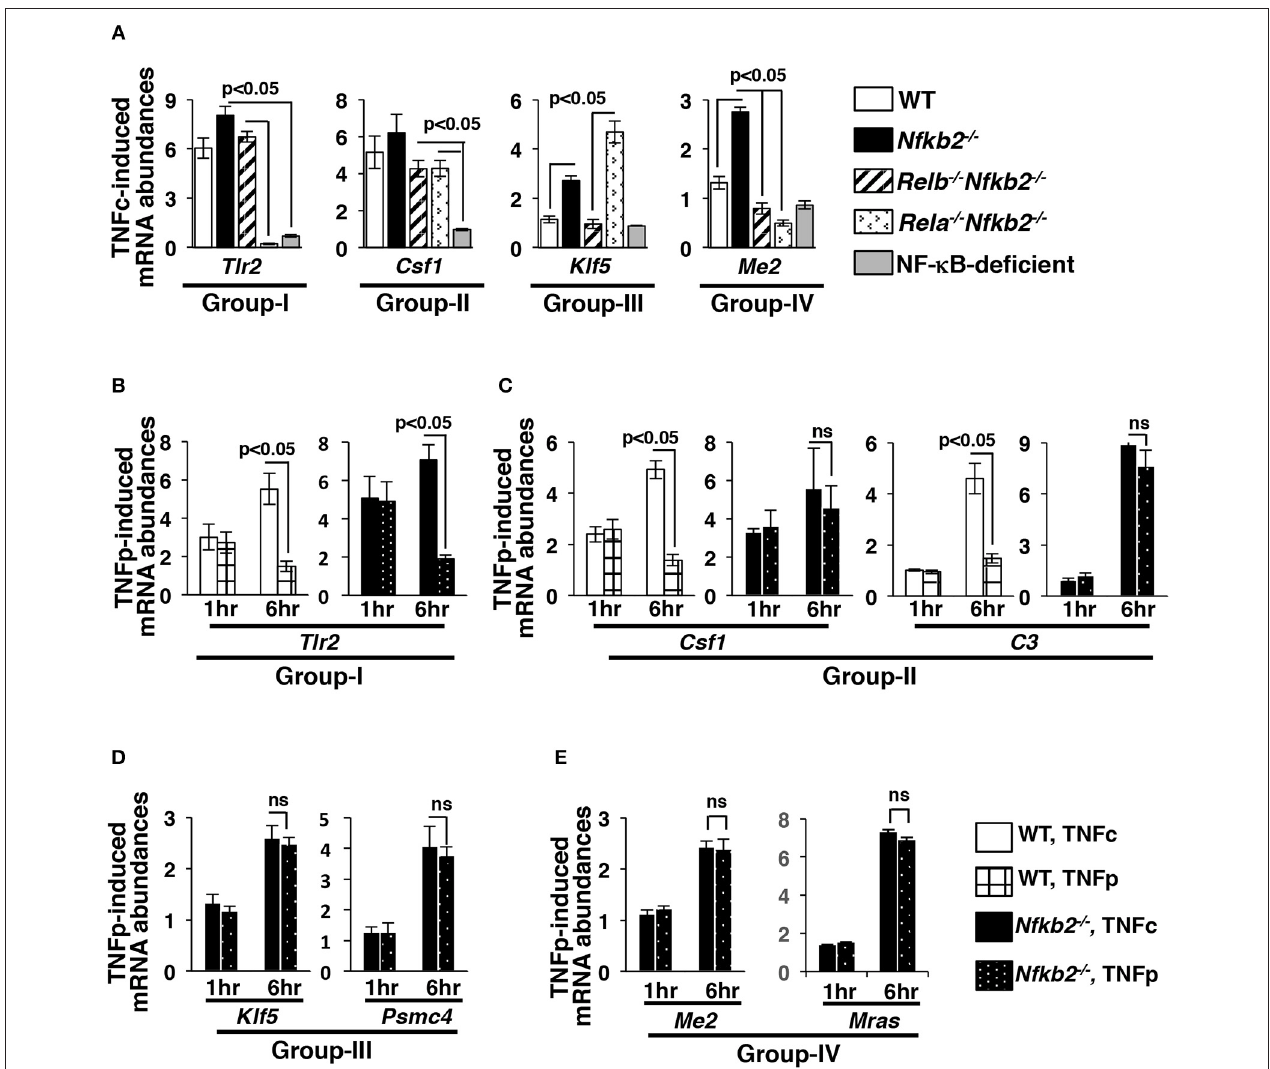
FIGURE 6 | Brief TNF stimulation induces delayed, RelB-dependent gene expression in Nfkb2 − / − MEFs. (A) WT and knockout MEFs were subjected to TNFc treatment for 6h, and the expressions of the indicated genes belonging to different gene-groups were measured by qRT-PCR. Bargraphs demonstrate the abundances of the corresponding mRNAs in stimulated cells relative to those measured in untreated cells. Data represent three biological replicates. (B–E) WT and Nfkb2 − / − MEFs were subjected to TNFc or briefly stimulated with TNF for 0.5h (TNFp), and subsequently cells were harvested at the indicated time-points before being subjected to qRT-PCR analyses. Bargraphs demonstrate TNF-induced expressions of the indicated genes, representing various gene-groups, in relation to untreated cells. Data represent four independent experiments. Quantified data presented in this figure are means ±